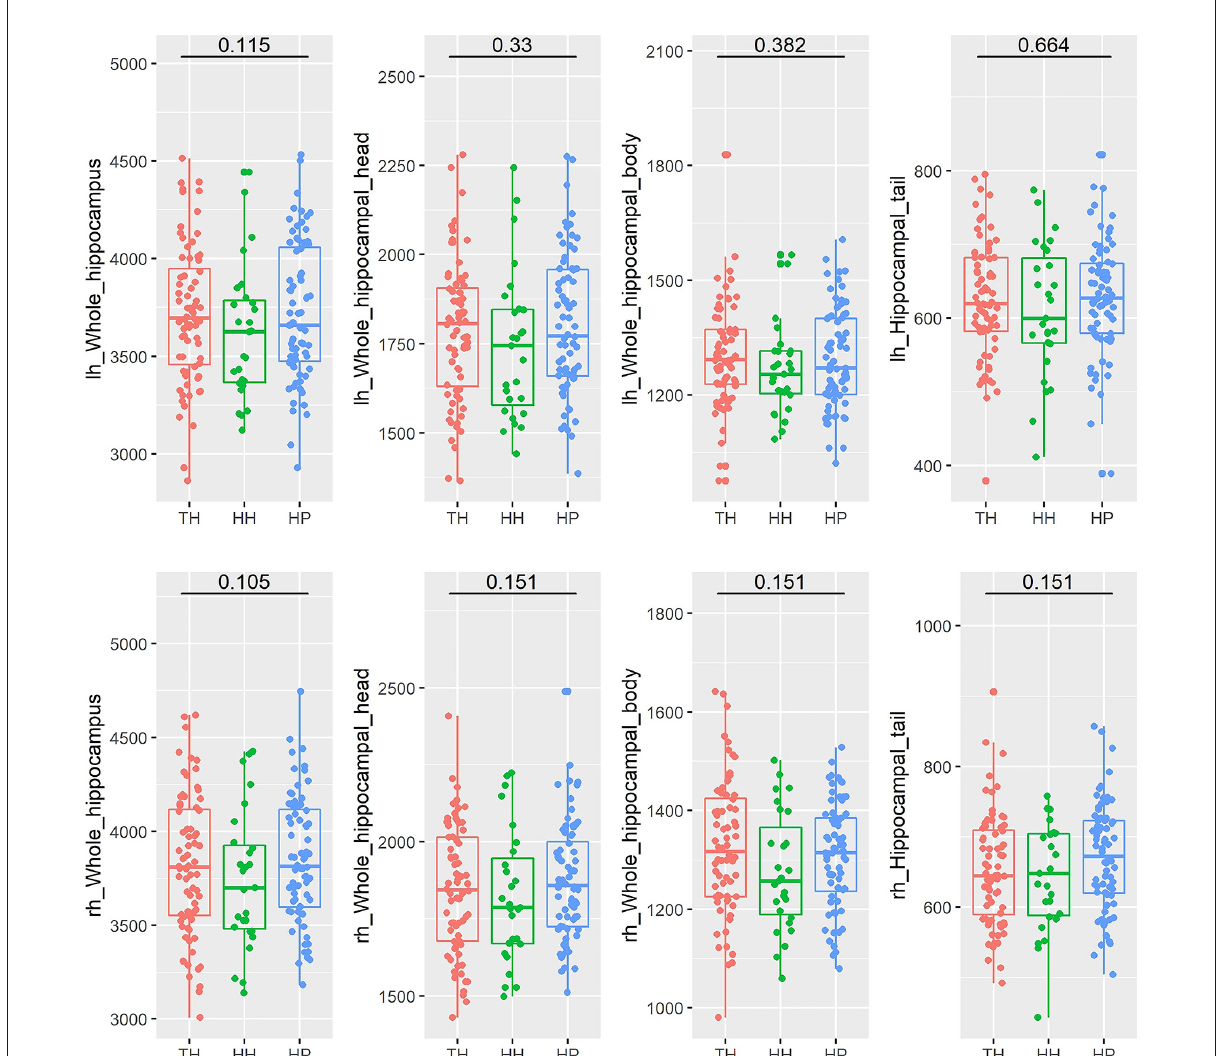
FIGURE2 Box plots of the volumes of the entire hippocampus and its subregions (head, body, and tail) in healthy Tibetan individuals living at high altitude (TH, adapted population, shown in red), Han Chinese individuals living at high altitude (HH, acclimatized newcomers, shown in green), and Han Chinese individuals living on the plain (HP, sea-level reference, shown in blue). The annotations show the FDR-corrected p values. lh, left hemisphere; rh, right